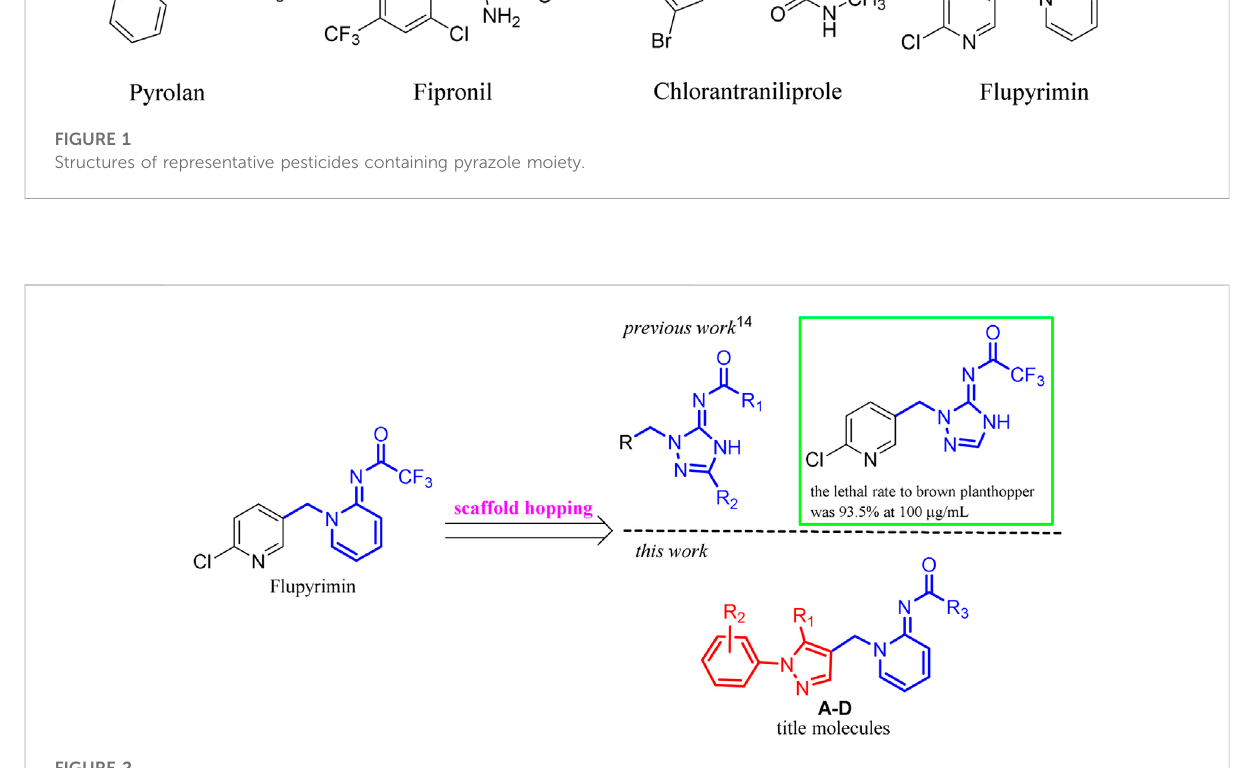
FIGURE 2 Design strategy of the title